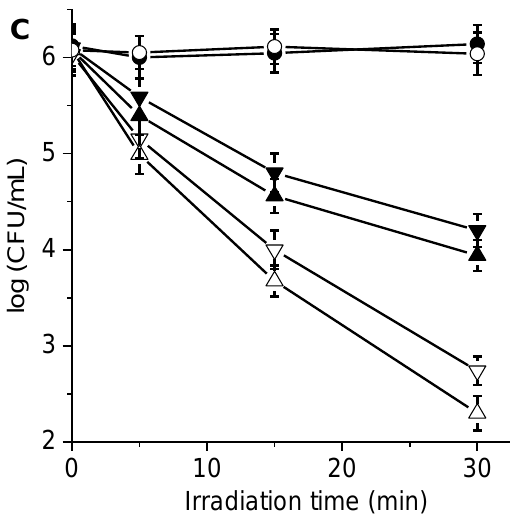
Figure 7. Survival curves of ( A ) S. aureus (~10 8 CFU/mL) treated with 1 µ M porphyrin, ( B ) E. coli (~10 8 CFU/mL) treated with 10 µ M porphyrin, and ( C ) C. albicans (~10 6 CFU/mL) treated with 5 µ M porphyrin for 30 min in the dark and irradiated with visible light for different periods. Additionally shown are porphyrin 6 in the absence ( θ ) and in the presence of KI ( σ ) and porphyrin 7 in the absence ( π ) and in the presence of KI ( (cid:52) ). S. aureus cells were incubated with 50 mM KI, and E. coli and C. albicans were incubated with 100 mM KI. Additionally shown are an irradiated control culture without porphyrin ( λ ) and irradiated control culture treated with KI without porphyrin ( ○ ).